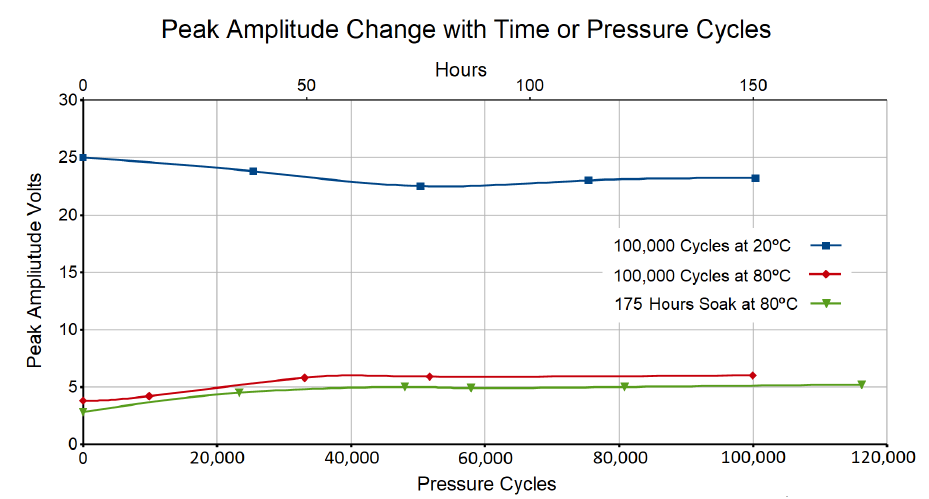
Figure 8. Change of peak amplitude with temperature and number of pressure